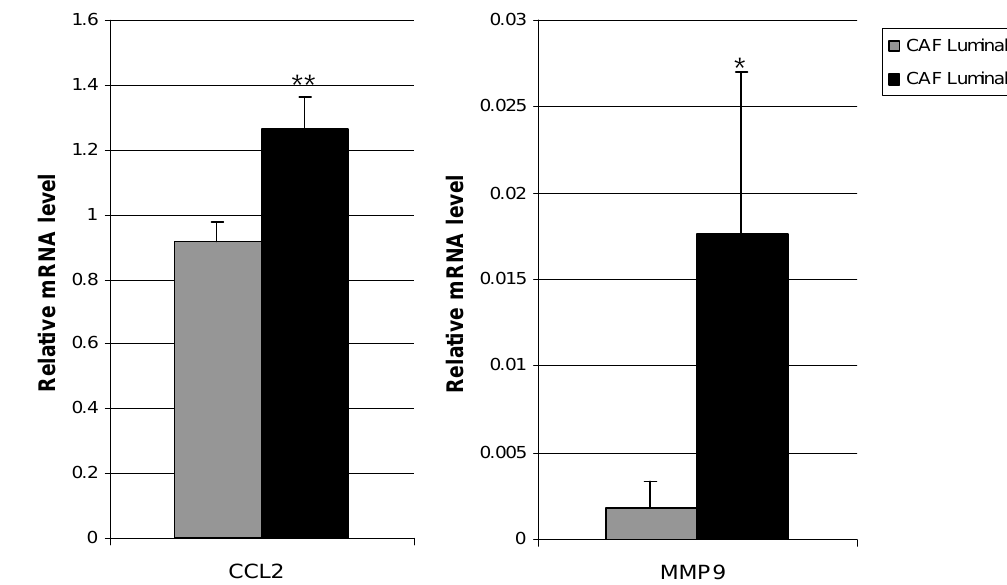
Figure 2. Real-time PCR analysis of factors assessed in CAFs from Luminal A and Luminal B breast cancer. Expression of CCL2 ( left ) and MMP9 ( right ). Data represent the mean ± SD (* p ≤ 0.05, ** p ≤ 0.001). For this analysis, performed in triplicate, all 19 patients were